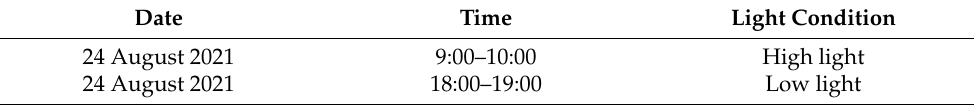
Table 1. Dataset collection times and light conditions in the complex orchard.